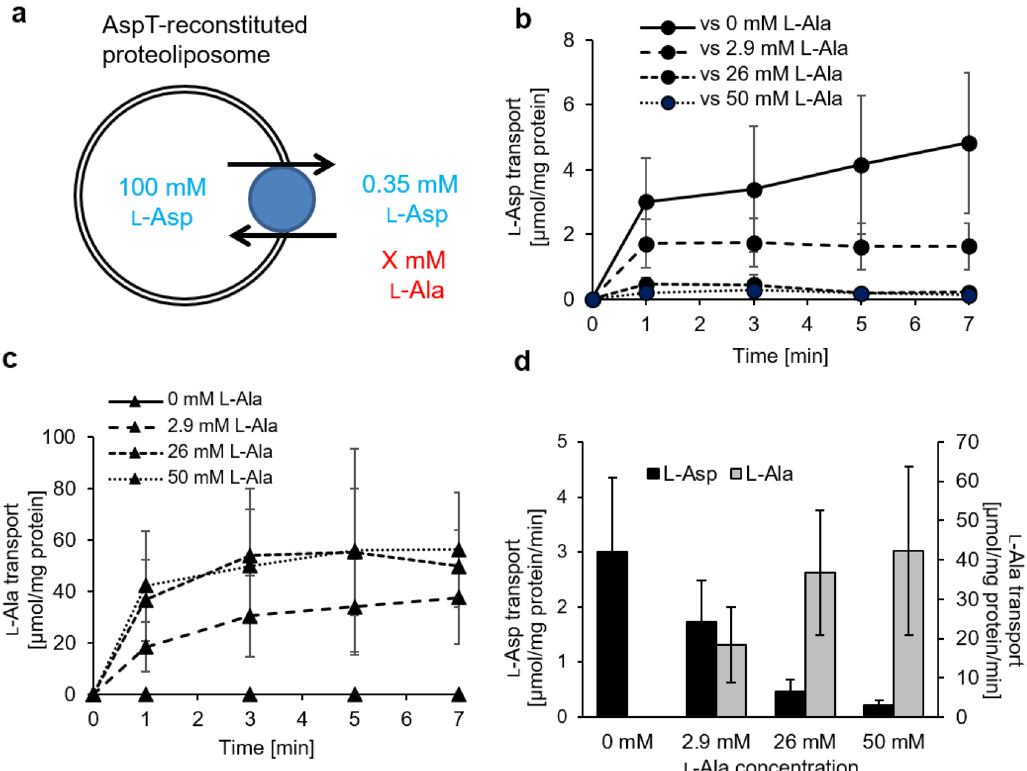
Figure 3. Inhibitive substrate transport assays of AspT. l-Ala and l-Asp movements were monitored by using two kinds of radioisotopes and AspT reconstituted into proteoliposomes. Proteoliposomes were loaded with 100 mM l-Asp (adjusted to pH 7 in N -methyl-d-glucamine [NMG]) and 50 mM potassium phosphate (pH 7) and then washed and resuspended as described in the Methods section. Proteoliposomes were placed in 50 mM NMG 2 SO 4 plus 50 mM potassium phosphate (pH 7.0) at 5 µg of protein/mL. l-Asp at 0.35 mM [the K m value] and plural l-Ala concentrations (0, 2.9 [1/10 V max ], 26 [ K m ], or 50 mM) were added to proteoliposomes at the same time ( a ), at which point 0.5 mM l-[ 14 C]aspartate ( b ) or 0.02 mM l-[ 3 H]alanine ( c ) was added. To estimate substrate exchange, aliquots were taken for filtration and washing at the times indicated (0, 1, 3, 5, and 7 min). ( b and c ) describe counterflow, and ( d ) shows the initial rate of l-Asp (black bars) or l-Ala (gray bars) uptake into proteoliposomes. Data are from three independent experiments with three replicates per condition and are presented as averages with